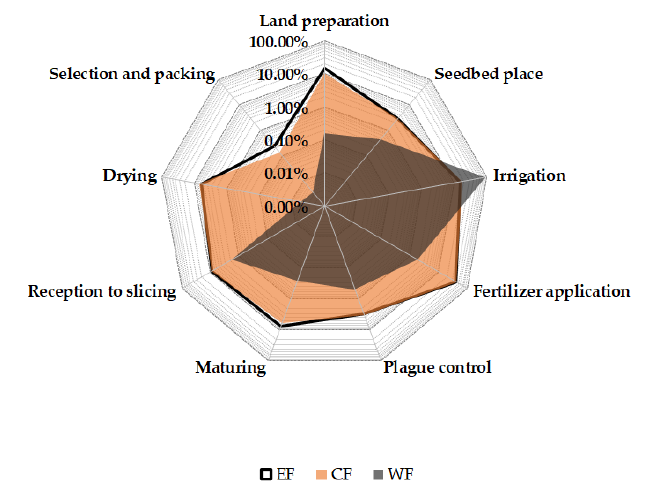
Figure 12. The carbon, water, and energy footprints of dehydrated pineapple by main unit processes.